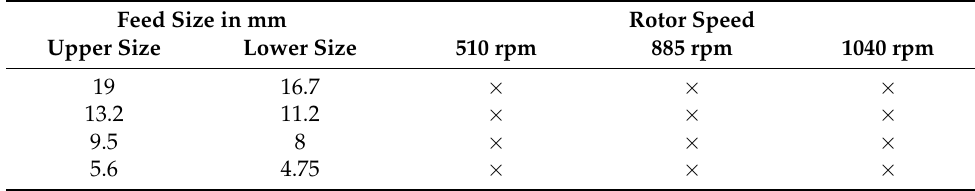
Table 2. Experimental